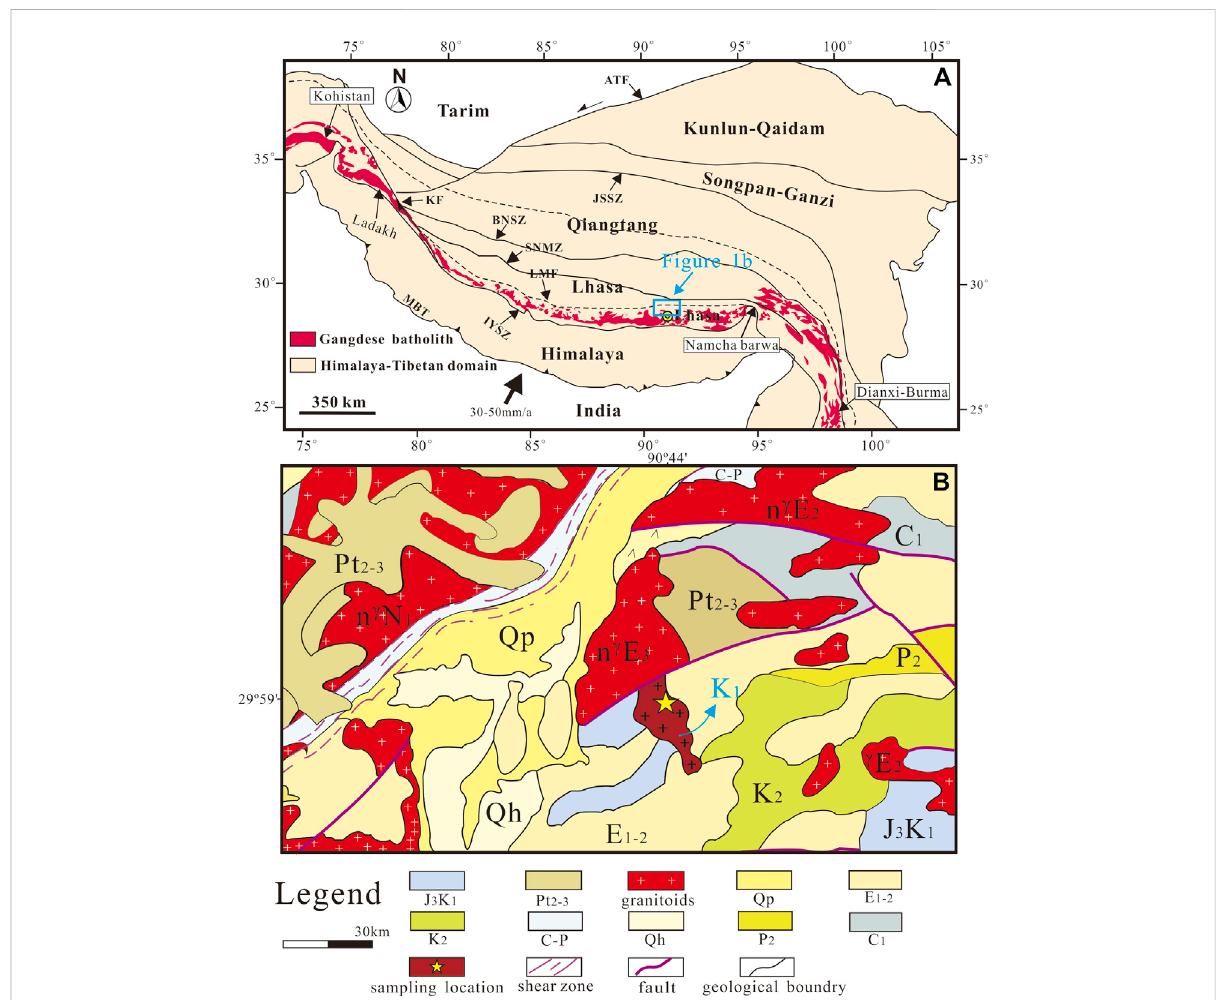
FIGURE 1 (A) Simpli fi ed tectonic framework of the Himalayan-Tibetan plateau (after Yin and Harrison, 2000; Zhu et al., 2011; Meng et al., 2021). (B) Regional geological map and sampling location (after 1:150, 0000 geological map of the Qinghai-Tibet Plateau and its adjacent areas) J 3 K 1 = Upper Jurassic-lower Cretaceous clastic rocks; E 1-2 = Palecene-Eocene mudstone/siltstone; K 2 = Upper Cretaceous clastic/depositional rocks, limestone; Pt 2-3 = Meso-Neo Proterozoic phyllite; Qh, Holocene sediments; Qp = Pleistocene clay, gravel; P 2 = Middle Permian clastic-volcanic rocks,; CP= Carboniferous- Permian limestone; C 1 = Lower Carboniferous limestone. Abbreviations: MBT, Main boundary thrust; IYSZ, Indus- YarlungZangbosuturezone;LMF,Luobadui-MilaMountainfault;KF,Karakoramfault;BNSZ,Bangong-Nujiangsuturezone; JSSZ,Jinshajiang suture zone; ATF, Altyn Tagh fault; SNMZ, ShiquanRiver-NamTso Melange